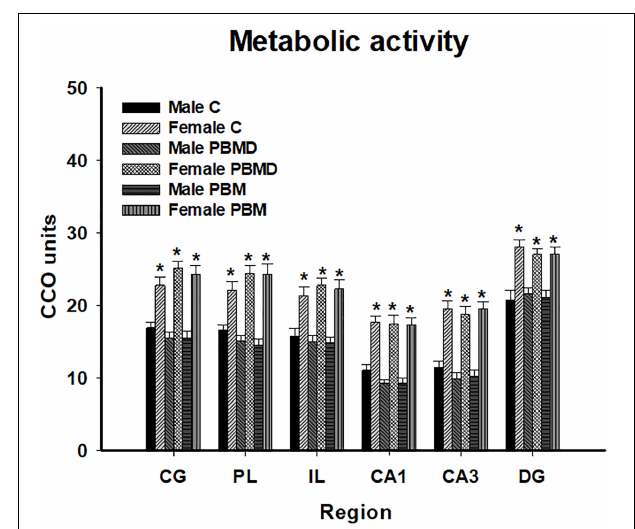
FIGURE 3 | CCO differences between sexes in the three groups (PBM, PBMD, and C) in each region of interest (mean ± SEM). Female groups showed a general pattern of higher metabolic activity in all the studied areas (* p < 0.05). Groups: C, control group; PBMD, photobiomodulation device group; PBM, photobiomodulation group. Areas: CG, Cingulate cortex; PL, Prelimbic cortex; IL, Infralimbic cortex; CA1,field CA1 of hippocampus; CA3, field CA3 of hippocampus; DG, Dentate Gyrus. PFC, prefrontal cortex; HPC, hippocampus; PND, postnatal day; CCO, cytochrome c